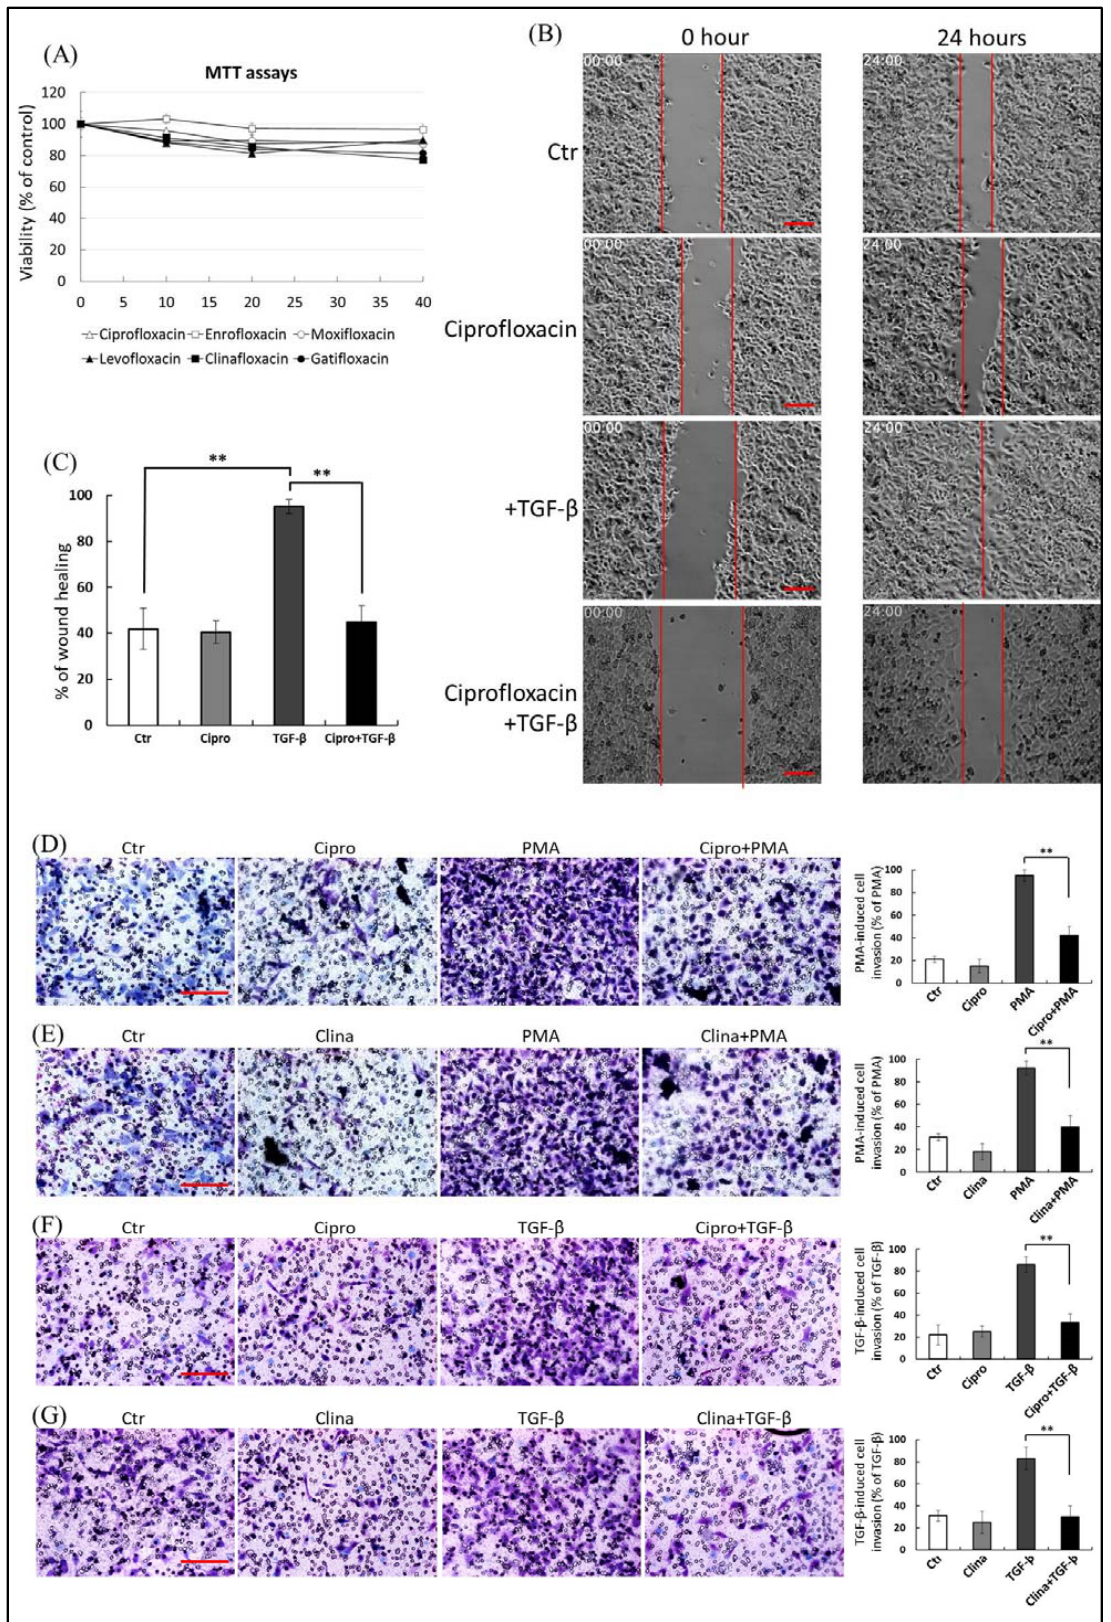
Figure 1. ( A ) A549 cells (1 × 10 4 /well in a 96-well plate) were treated with 1–40 µ M of fluoroquinolones (FQs; ciprofloxacin, enrofloxacin, moxifloxacin, levofloxacin, clinafloxacin, and gatifloxacin) for 48 h. Cell viability of cells was determined